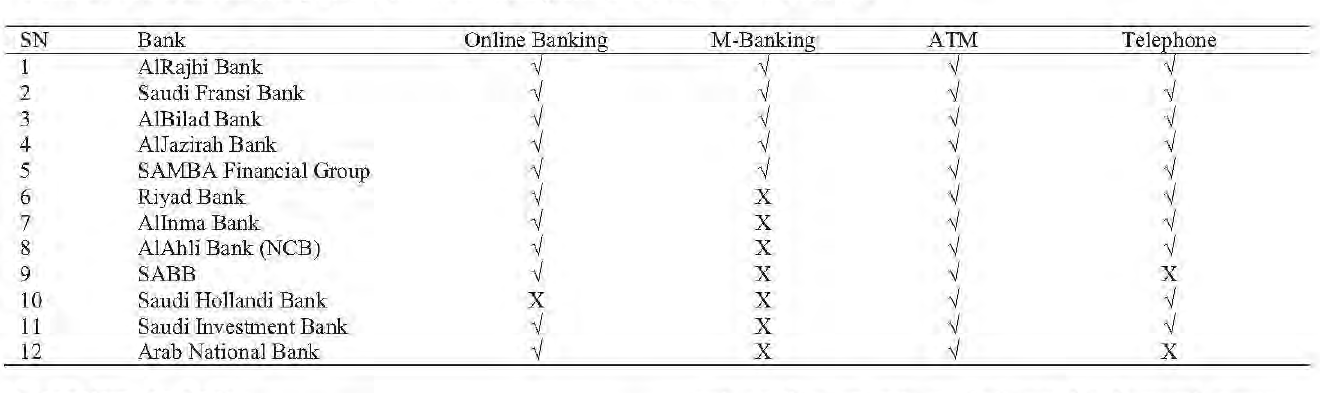
Table 2: Saudi banks that provide mobile banking and other electronic channels SN Bank Online